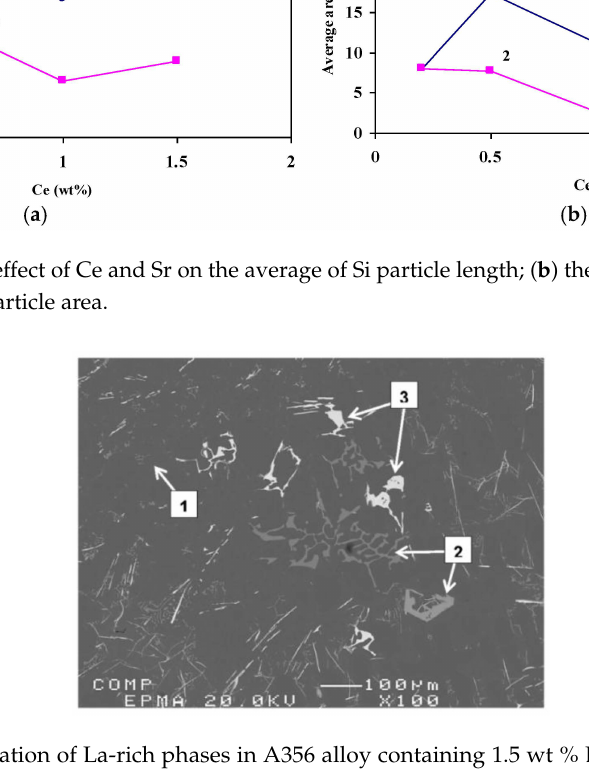
Figure 14. Precipitation of La-rich phases in A356 alloy containing 1.5 wt % La (T3 alloy): (1) α -Al; (2) α -Fe and (3) La-rich